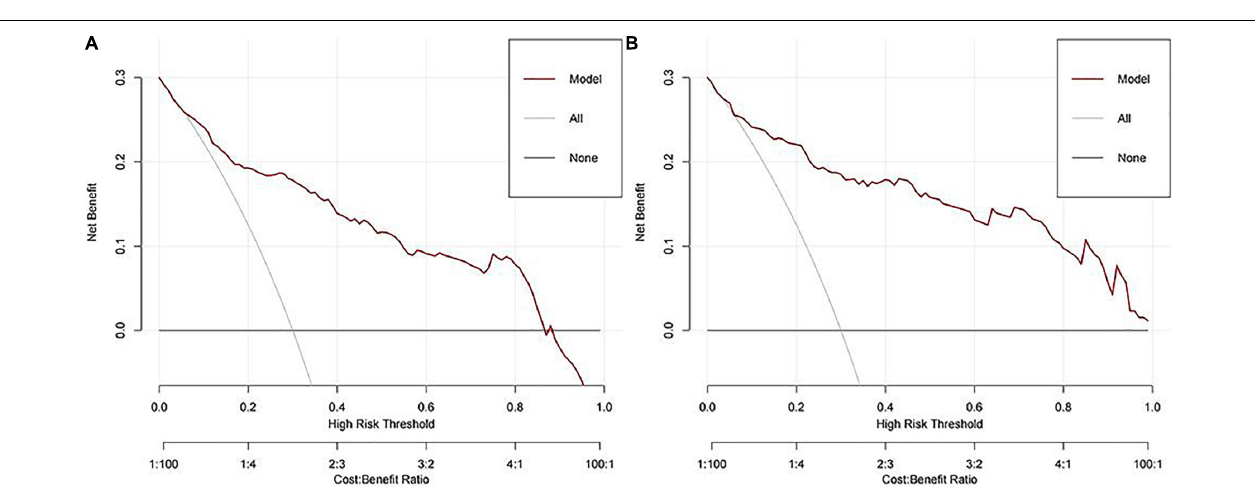
FIGURE 3 | Decision curve analyses (DCA) of our model. (A) Training cohort. (B) Validation